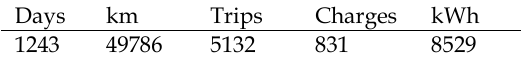
Table 12 Total sample electric mobility profile